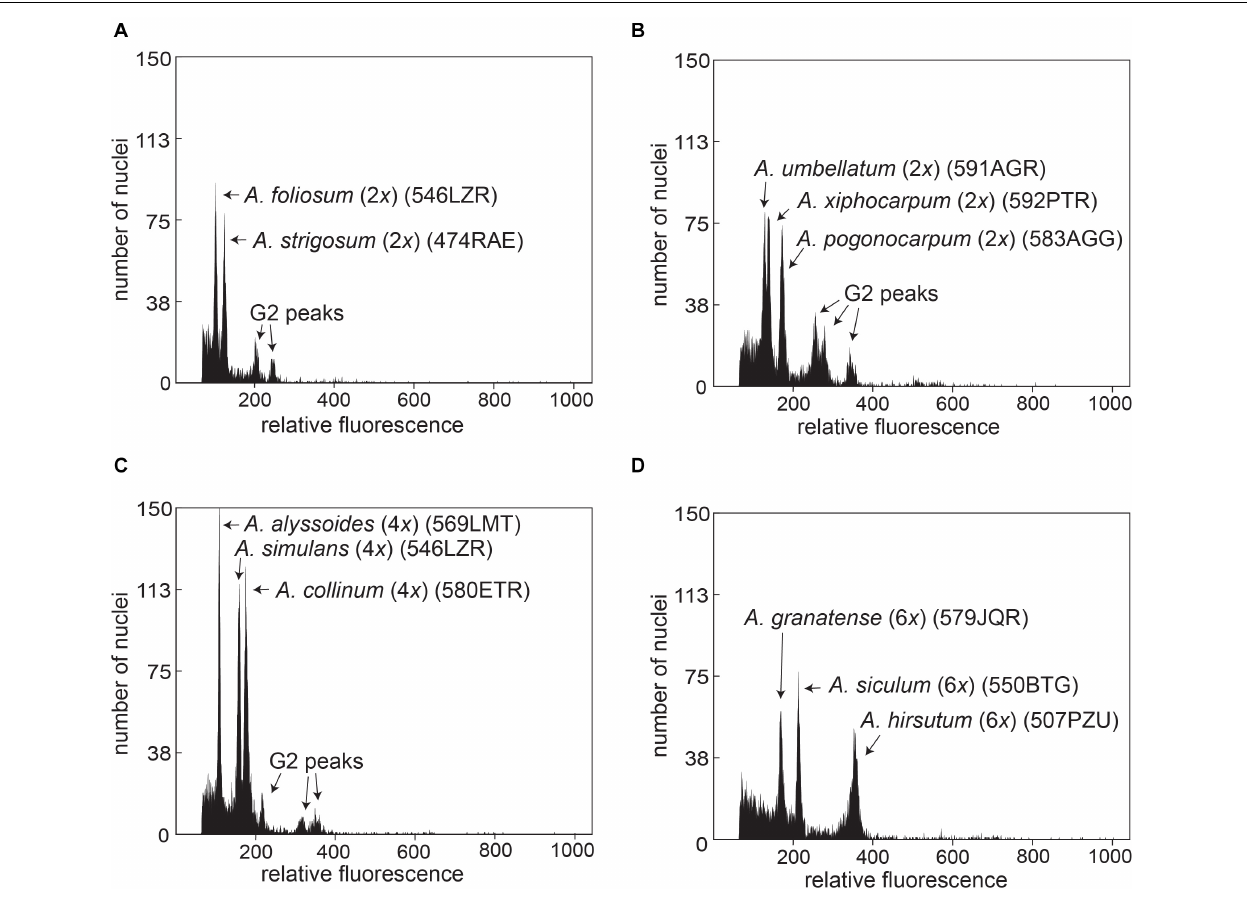
FIGURE 3 | Simultaneous FCM analyses of Alyssum species, illustrating the differences in relative genome size values (relative fluorescence) between selected diploid (A,B) , tetraploid (C) , and hexaploid (D) species. For population codes, see Supplementary Table 1 .